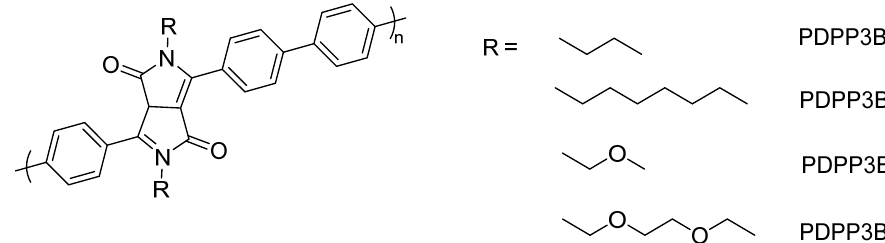
Figure 10. Co-polymers of phenylene and diphenyl diketopyrrolopyrrole with different side-chains to investigate their effect on the materials’ wettability and influence on their performance for sacrificial photocatalytic hydrogen generation from water [96].